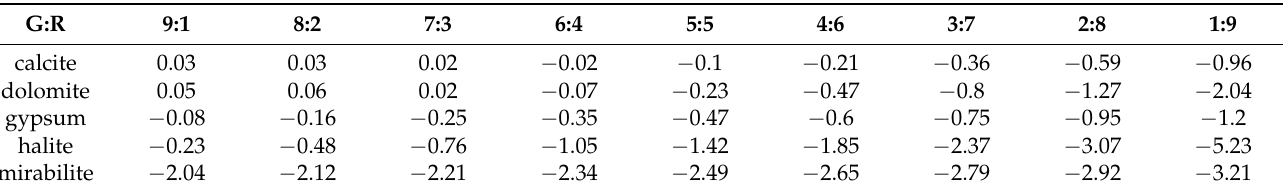
Table 5. Simulation Results of SI in Different